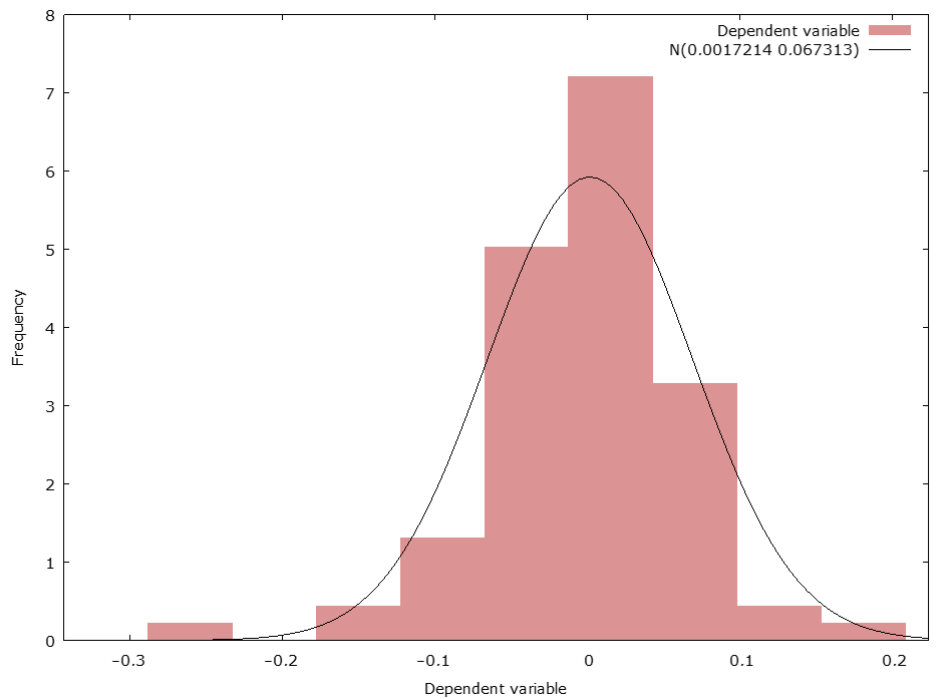
Figure 2. Histogram of the normal distribution of the dependent variable of the European model.